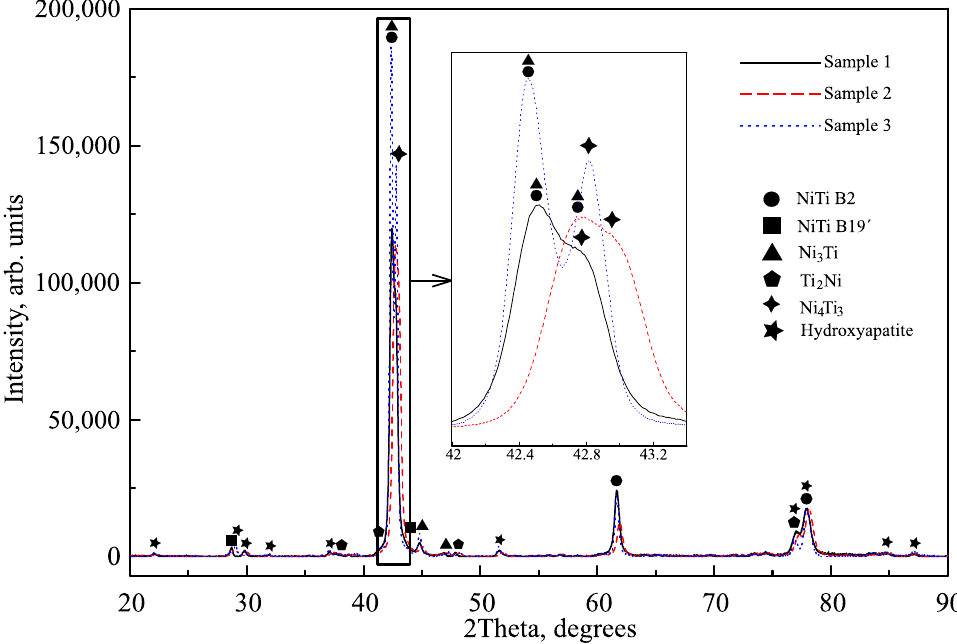
Figure 1. XRD pa tt erns of NiTi samples with hydroxyapatite coatings deposited for 1, 2, and 3 h Figure 1. XRD patterns of NiTi samples with hydroxyapatite coatings deposited for 1, 2, and 3 h (samples 1, 2, and 3). (samples 1, 2, and 3).